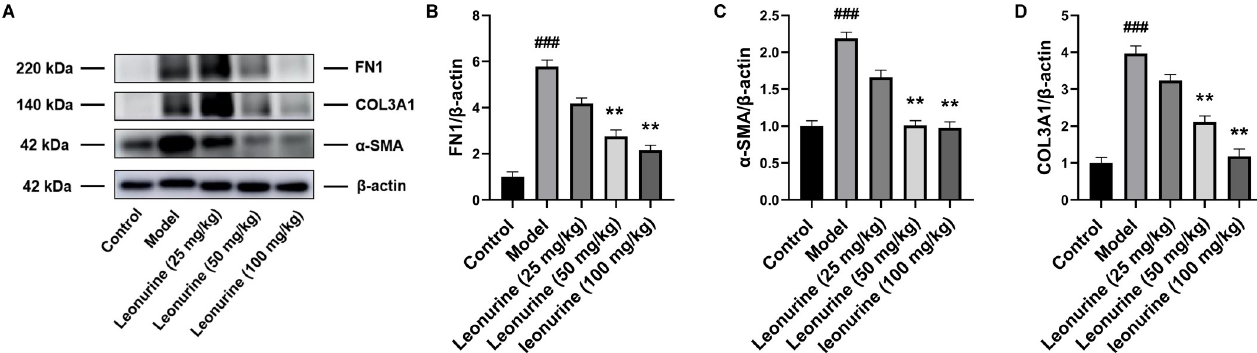
Fig 4. Leonurine reduced the expression of proteins related to fibrosis in heart tissues from rats with ISO-induced heart failure. (A) Compared to ISO- induced rats, leonurine decreased the expression of proteins related to fibrosis including (B) FN1, (C) α -SMA, and (D) COL3A1. ##P < 0.01, ###P < 0.001, model group vs. control group; �� P < 0.01, leonurine groups vs. model